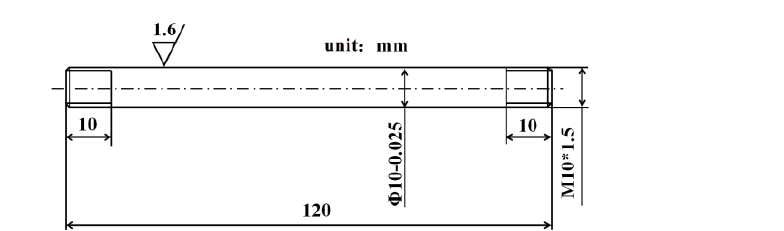
Figure 1. Shape of specimens for hot tensile tests.